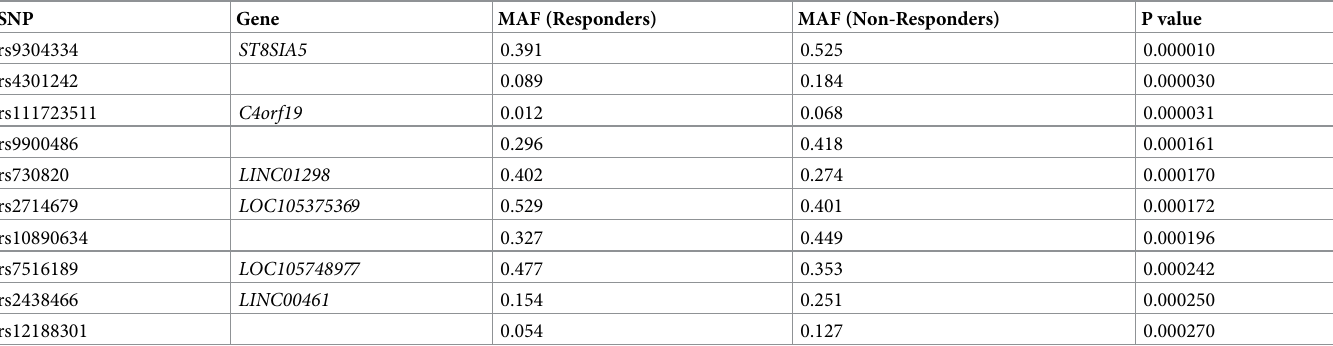
Table 3. Strongest associations for genome-wide variants.